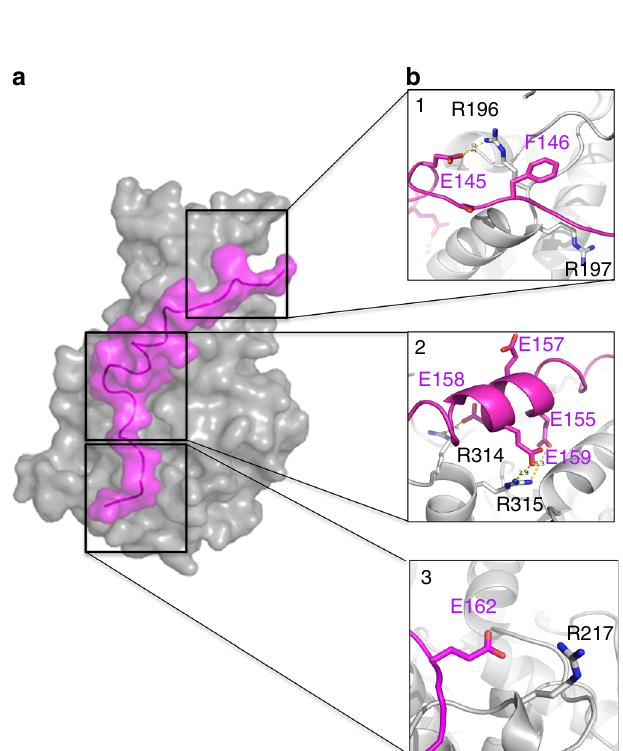
Fig. 5 Model of CegC3 ’ s Glu-rich tail peptide bound to DotM153. a Surface representation of wild-type DotM153 (gray) in complex with the CegC3 peptide (magenta). See Methods section for modeling. b Zoom in into CegC3 (magenta) peptide interactions with DotM (gray). Interacting residues are shown in stick representation, color-coded blue and red for N and O atoms, and either magenta or gray for C atoms of the peptide and the protein, respectively. Panels 1 – 3 focus on the three areas, M1, M2, and M4, respectively, which were targeted for mutations, and for which binding was